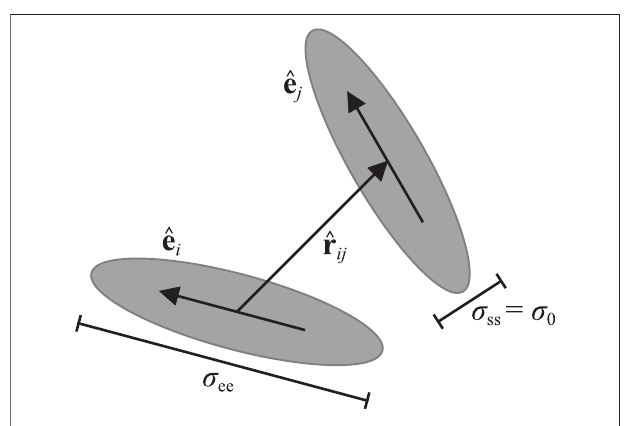
FIGURE 1 | Schematic de fi ning the degrees of freedom and parameters associated with the GB ( 3 , 5 , 2 , 1 ) mesogens. Molecular axes are de fi ned by unit vectors (cid:1) e i and (cid:1) e j .Thecenter-to-centerunitvector (cid:1) r ij temperstheinteractionpotential relative to mesogen-mesogen orientation, affecting both length [ Eq. 2 ] and energy[ Eq.5 ]scales.Theinteractionpotentialisscaledbyamodellength σ 0 de fi ned withrespecttotheside-sidelength σ ss .Theend-endlength σ ee isusedtode fi nethe molecular aspect ratio; for the parameterization used in this work, σ ee / σ ss (cid:2)